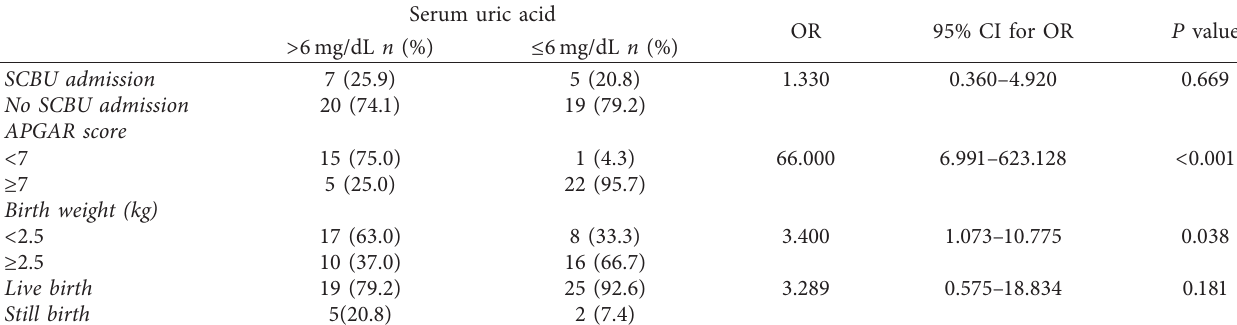
Table 6: Association between serum uric acid levels and pregnancy